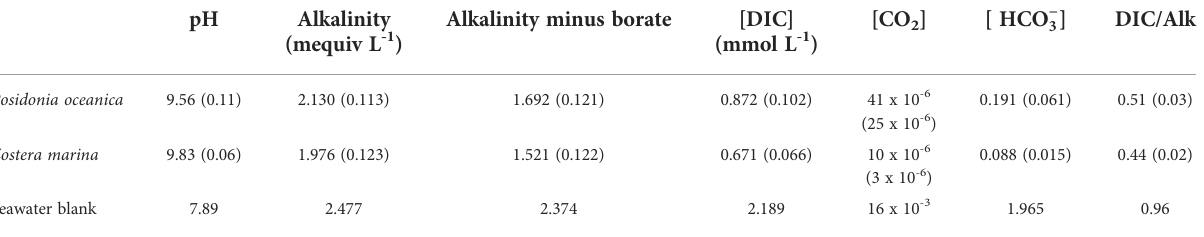
TABLE 1 Concentrations of inorganic carbon at the end of pH drift experiments at 20°C in fi ltered natural